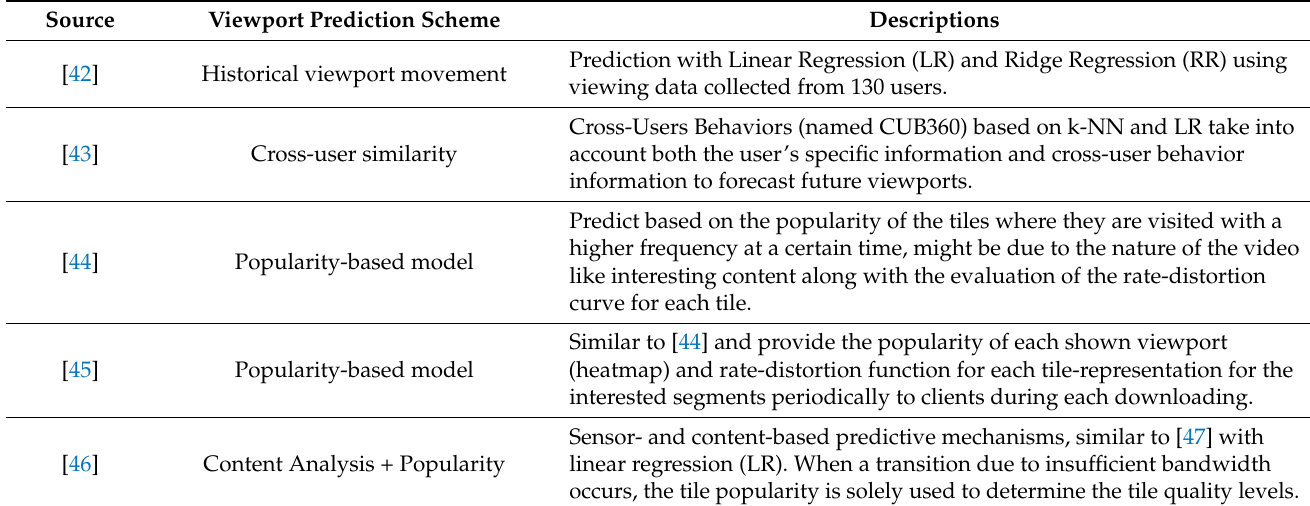
Table 4. Viewport prediction scheme of the viewport adaptive streaming